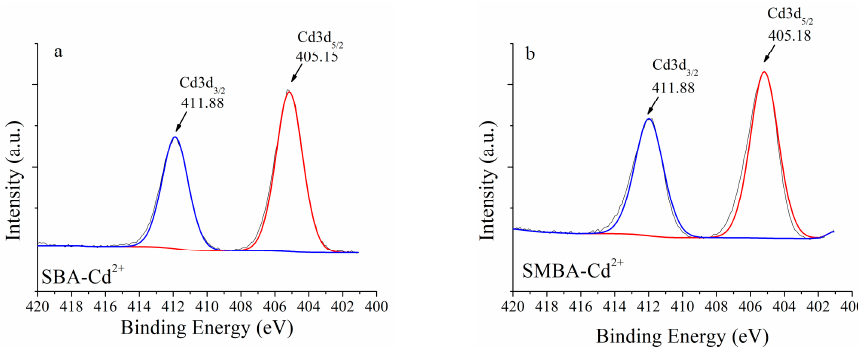
Figure 5. XPS spectra of ( a ) Cd3d for SBA, ( b ) Cd3d for SBMA.